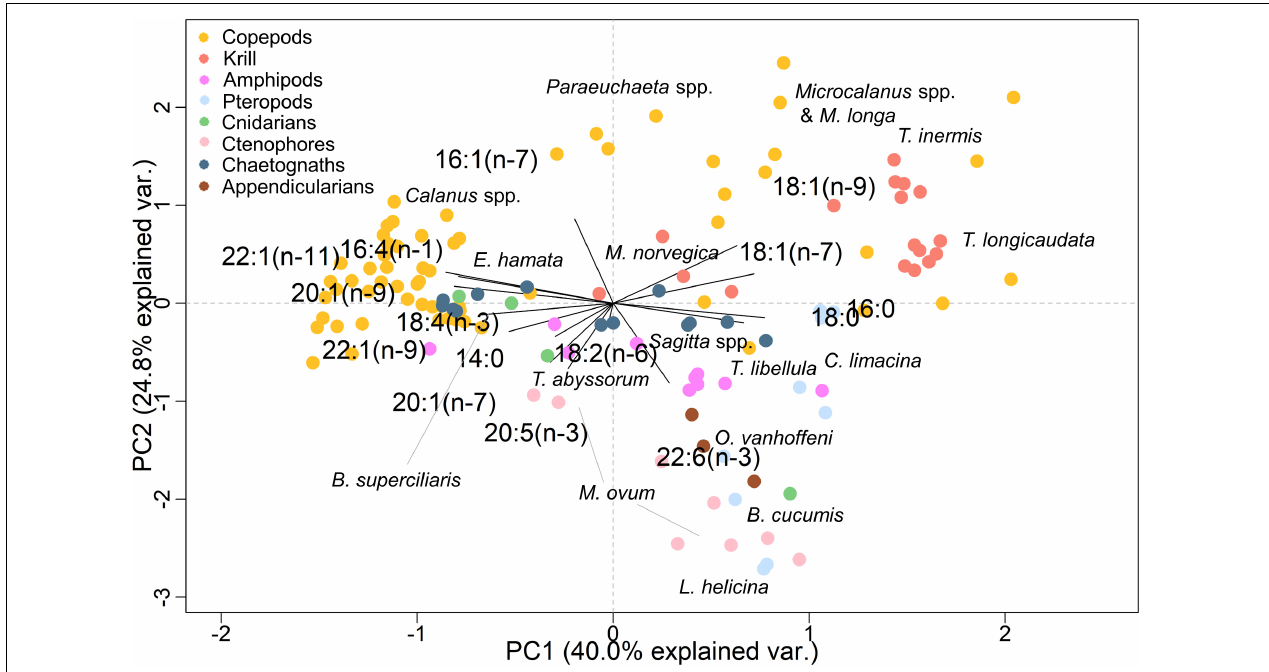
FIGURE 3 | Principal component analysis (PCA) of fatty acids (FAs; ≥ 1% to the total FA content) in the zooplankton collected during Nansen Legacy cruise Q3 in August 2019 in the Barents Sea. Relative proportions of individual FAs are shown in Supplementary Table 3